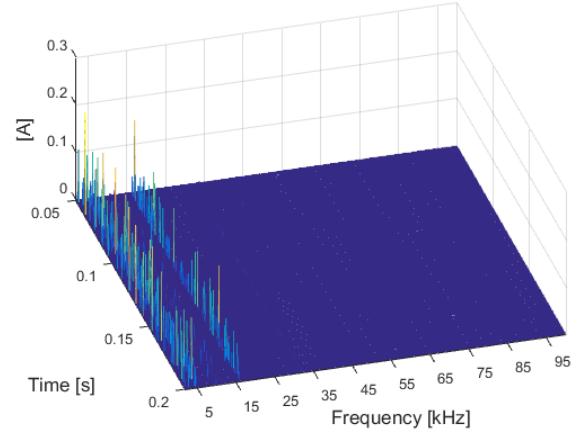
Figure 11. Case study 1: 3D representation of the high-frequency spectra obtained by means the instantaneous approach of SWWMEM.